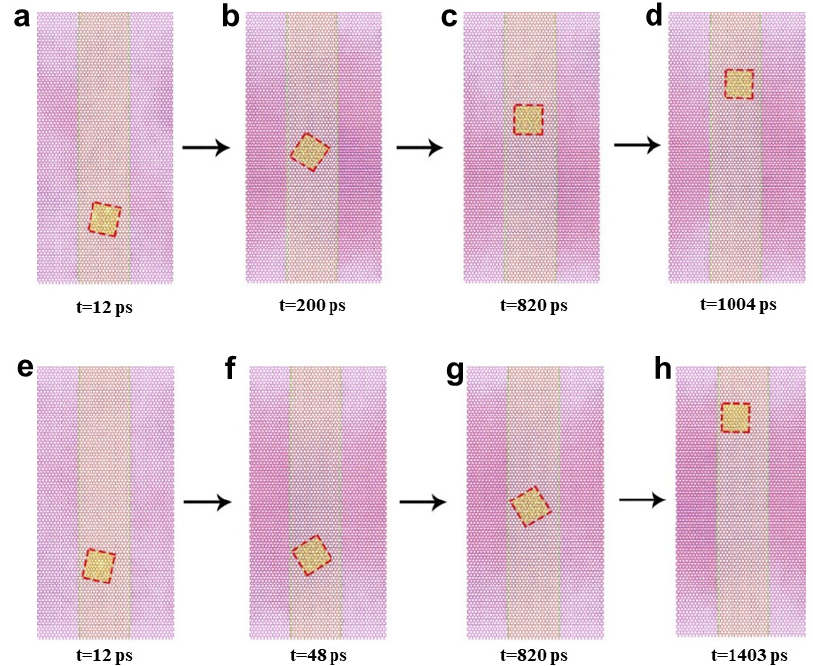
Figure 5. The snapshots of two systems during the movement. ( a – d ) Hydrogen-passivated graphene nanoflake. ( e – h ) Pristine graphene nanoflake. nanoflake. ( e – h ) Pristine graphene